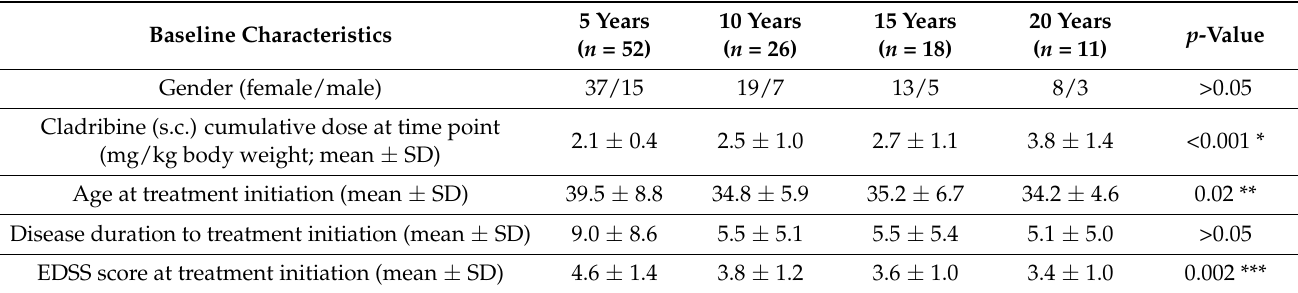
Table 2. Baseline characteristics based on cumulative duration of